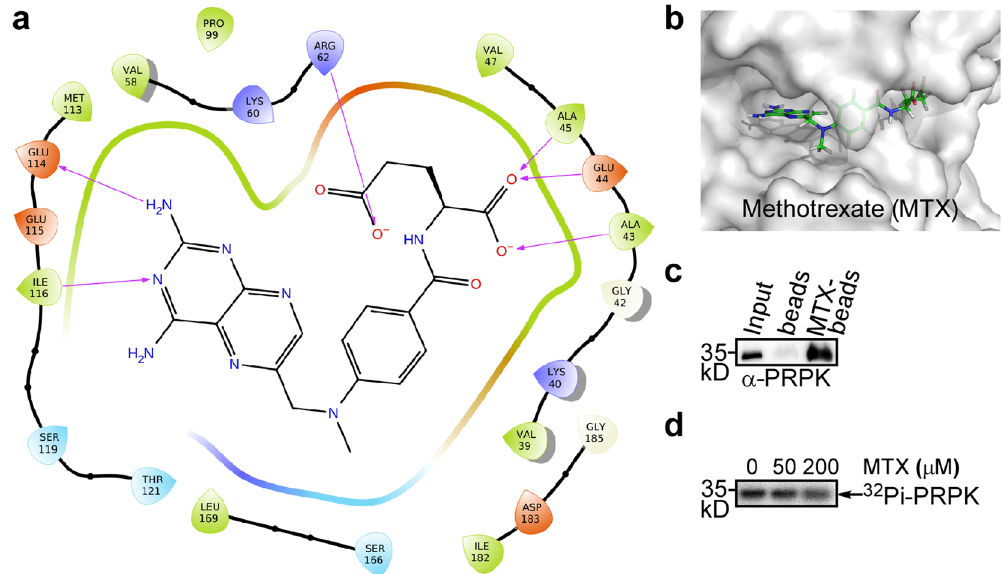
Fig. 5 Identi fi cation of methotrexate as a PRPK inhibitor. a Detailed MTX binding interactions with PRPK. b MTX fi ts nicely to the PRPK ATP binding pocket. c The binding of MTX to PRPK was con fi rmed by in vitro pulldown assay using MTX-agarose. d Inhibition of PRPK – TPRKB autophosphorylation activity by MTX. Uncropped images of blot and autoradiograph are shown in Supplementary Fig.